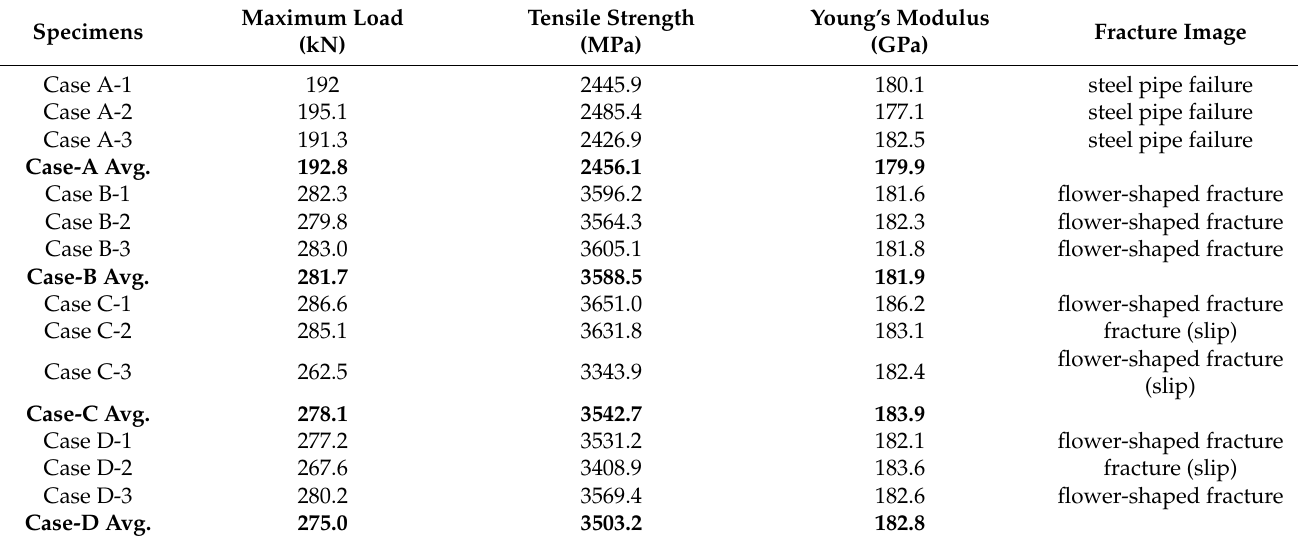
Table 6. Bond performance outcomes for tested